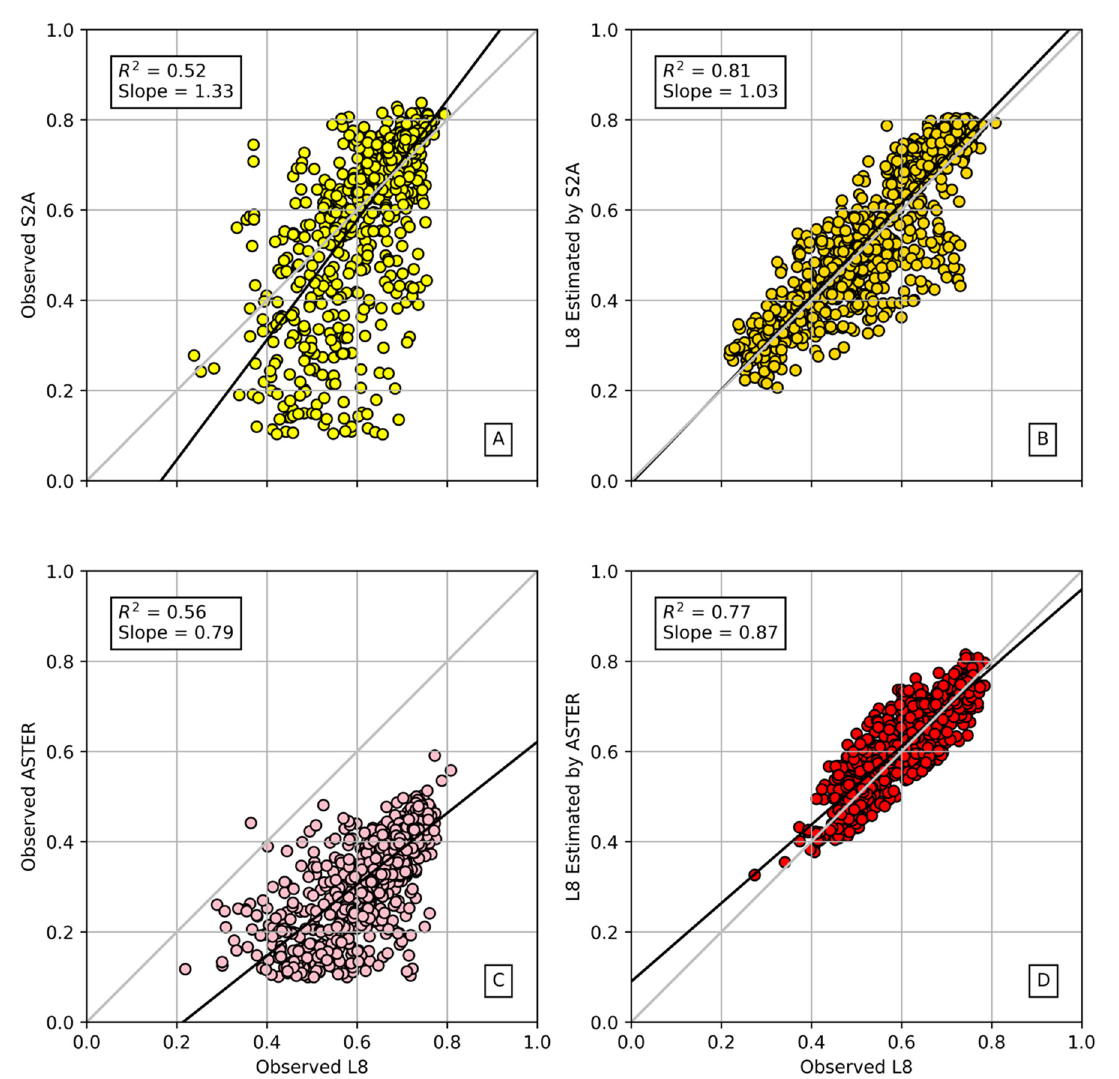
Figure 7. Comparison of observed NDVI differences between sensors and subsequent adjustments for 1000 randomly selected pixels in May 2018. Subfigure ( A ) shows Observed S2A versus Observed L8, ( B ) Random Forest Adjusted S2A versus Observed L8, ( C ) Observed ASTER versus Observed L8, and ( D ) Random Forest Adjusted ASTER versus Observed L8.